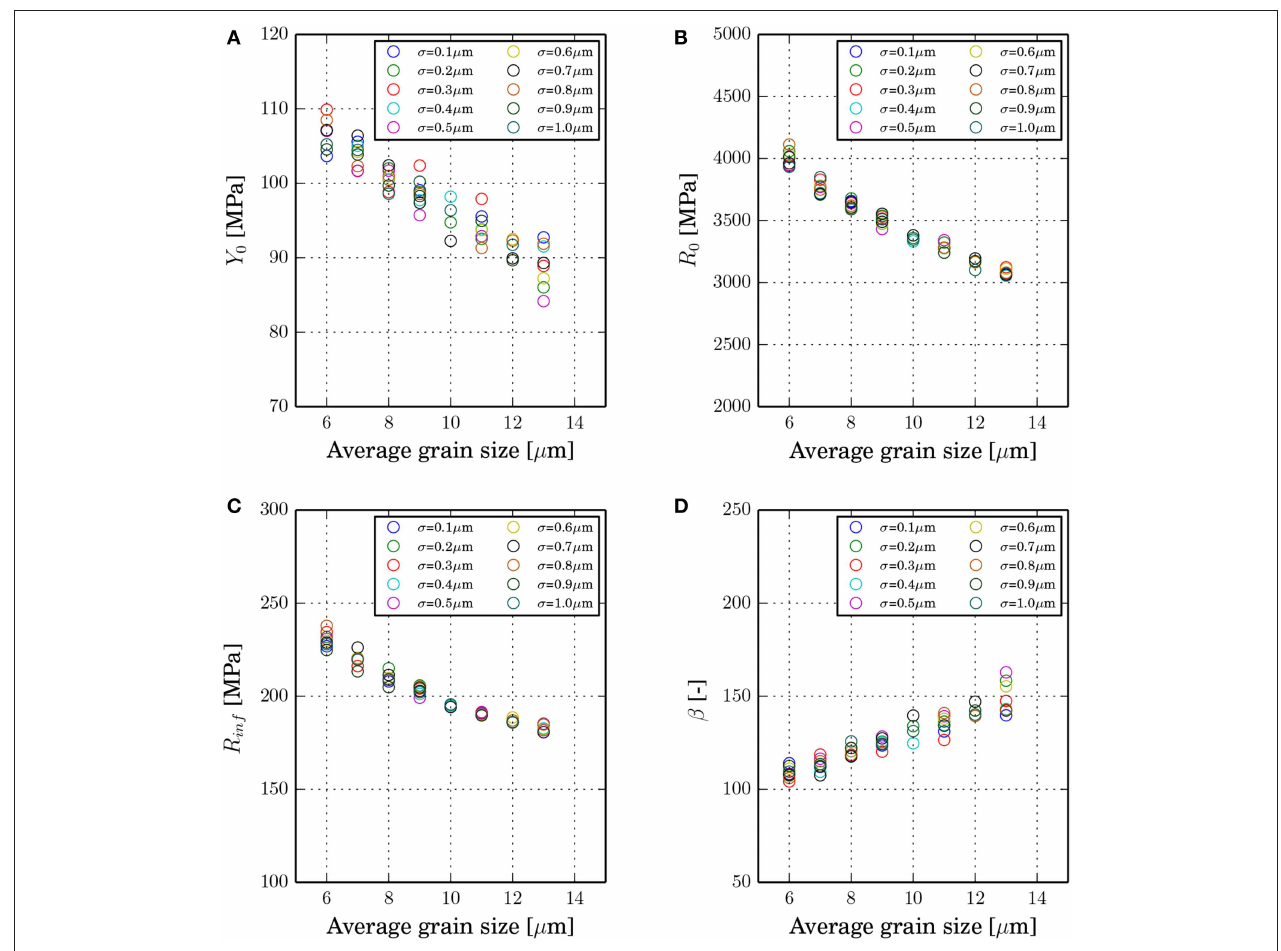
FIGURE 10 | Influence of the average grain size on fitted material parameters of the modified Voce law (A) Y 0 , (B) R 0 , (C) R inf , and (D) β .